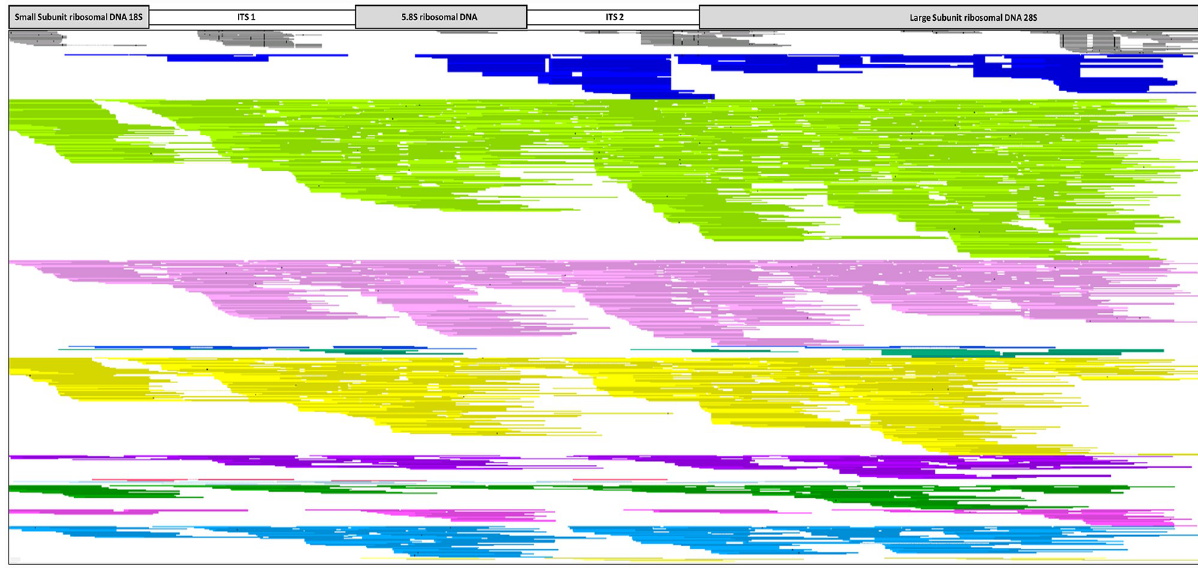
Fig 5. Vision 2.6.24 image of 13 illumina nextera XT 1 VPRI 18536 DNA extraction protocol libraries mapped to P . leucotricha ITS (GenBank accession no. KX842350.1) including P . tridactyla as an outgroup for comparison. Continuous unbroken lines represent sequence reads that completely align to the reference sequence. Gaps in the alignment indicates no mapping sequence reads, and SNPs between the mapped read and the reference are represented as black bars. Colour code: Grey- P . tridactyla , Dark Blue- CheX (Chelex 1 100), Light Green- InuP (innuPrep Plant DNA), Light Pink- SDS (sodium dodecyl sulphate), Blue- EznS (E.Z.N.A. 1 SP Plant), Green- DnaZ (DNAzol ™ ), Yellow- EznF (E.Z.N.A. 1 Forensic DNA), Purple- DneP (Qiagen DNeasy 1 Plant), Red- IspC (Isolate II Plant DNA Lysis buffer PA1 C), Light Blue- IspS (Isolate II Plant DNA Lysis buffer PA2 S), Dark Green- WizG (Wizard 1 Genomic DNA Purification), Light Blue- EznP (E.Z.N.A. 1 Plant), Dark Pink- CTAB (Cetyl trimethyl ammonium bromide) and Light Yellow- DneP+ (Qiagen DNeasy 1 Plant plus PTB).